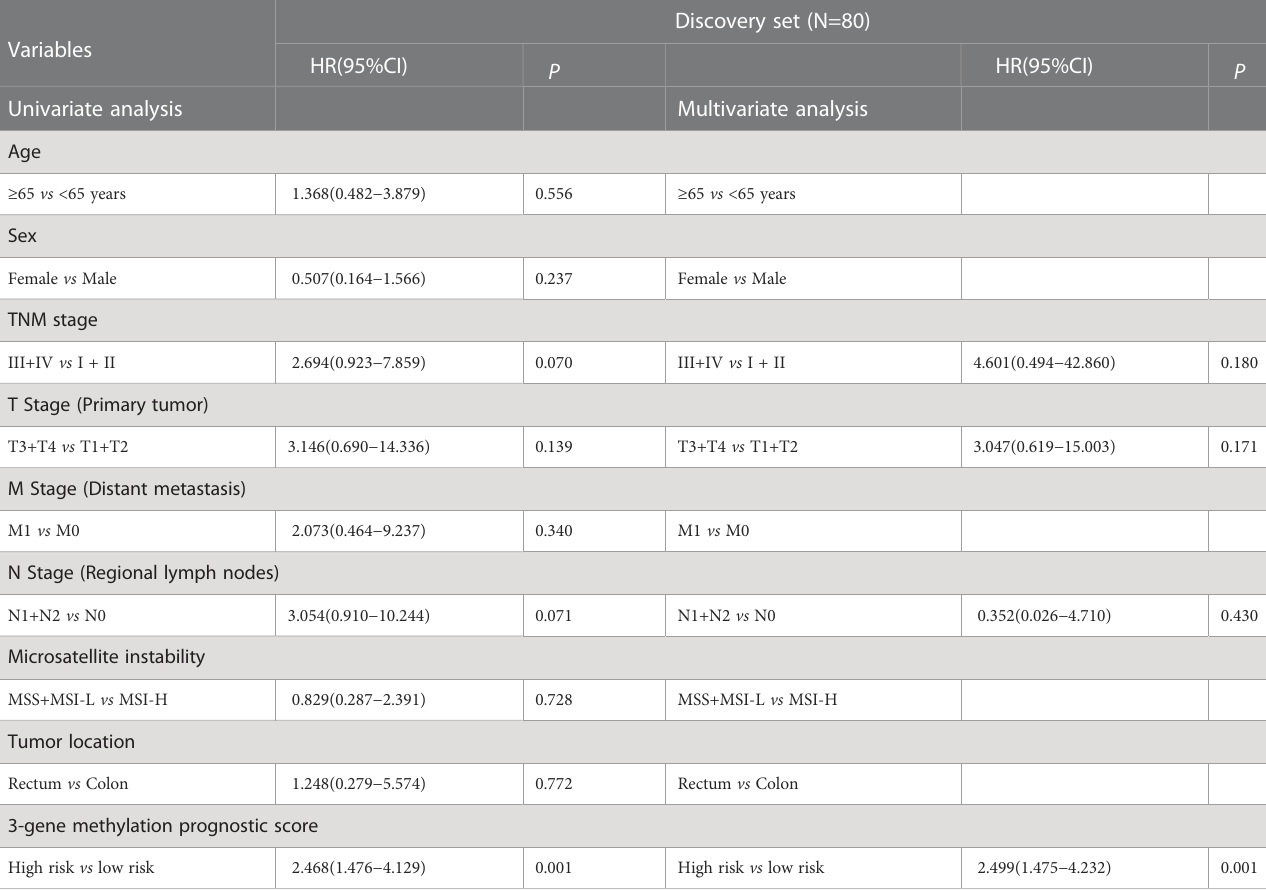
TABLE 2 Univariate and multivariate Cox regression analysis of the 3-gene methylation signature.